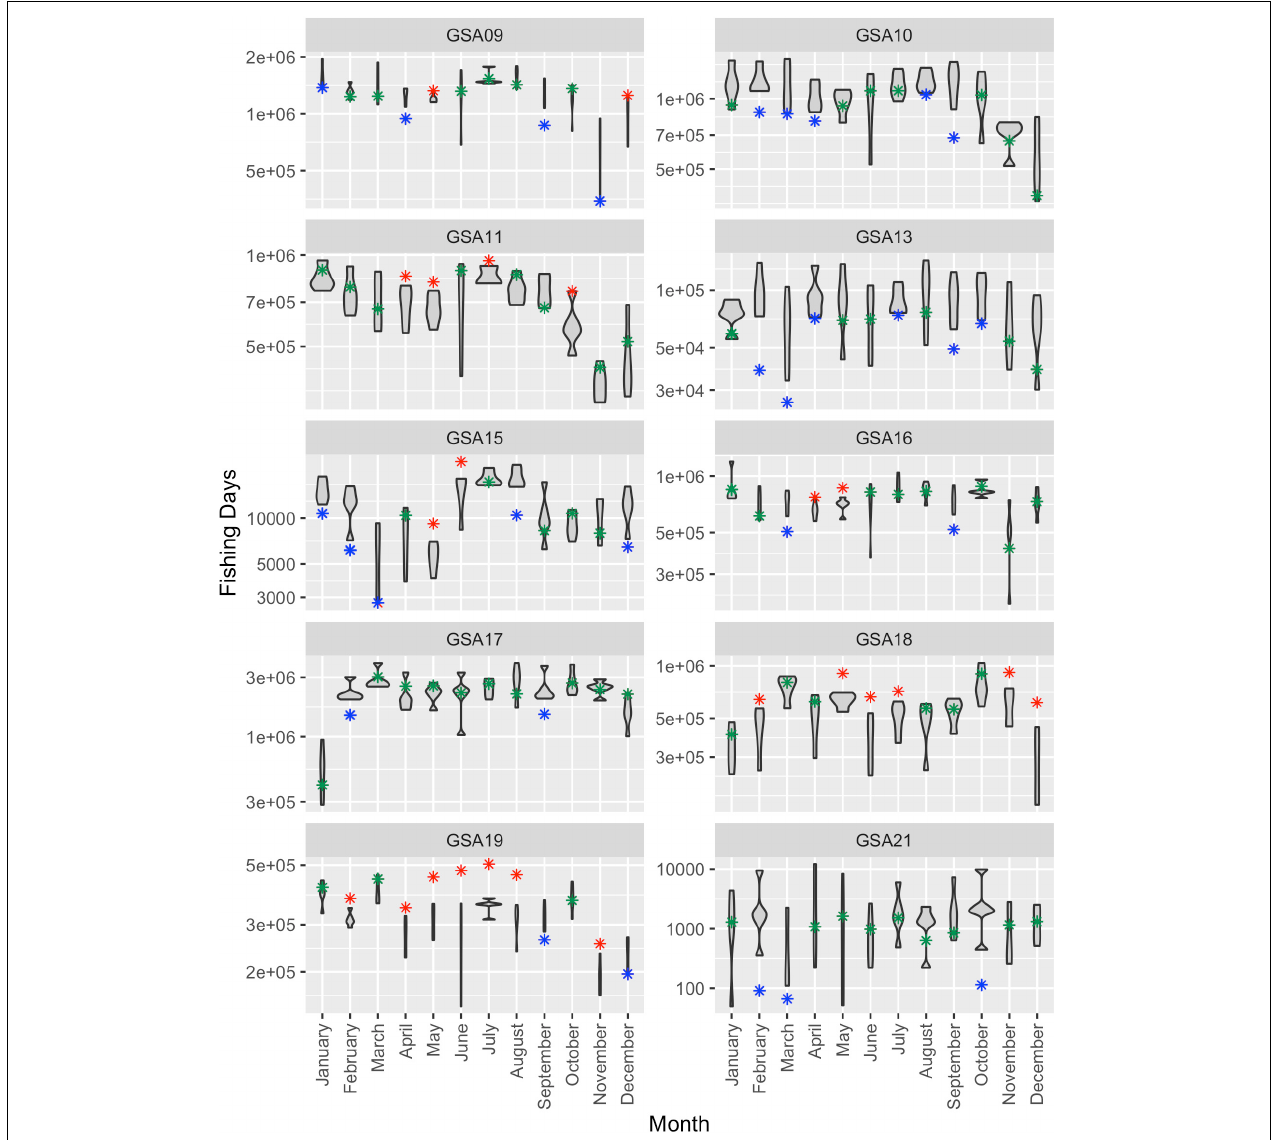
FIGURE 2 | Violin plot of the values of total Fishing Effort (in Days) by month and GSA. The values of the years 2015–2019 are represented by the violin, while those of the year 2020 (during the pandemic) are represented as asterisks colored in red when significantly higher than those in the reference period, in blue when significantly lower than those in the reference period and in green when coherent with those in the reference period. A violin plot is a plotting method similar to a box plot, since it shows the probability density of the data at different values, smoothed by a kernel density estimator.